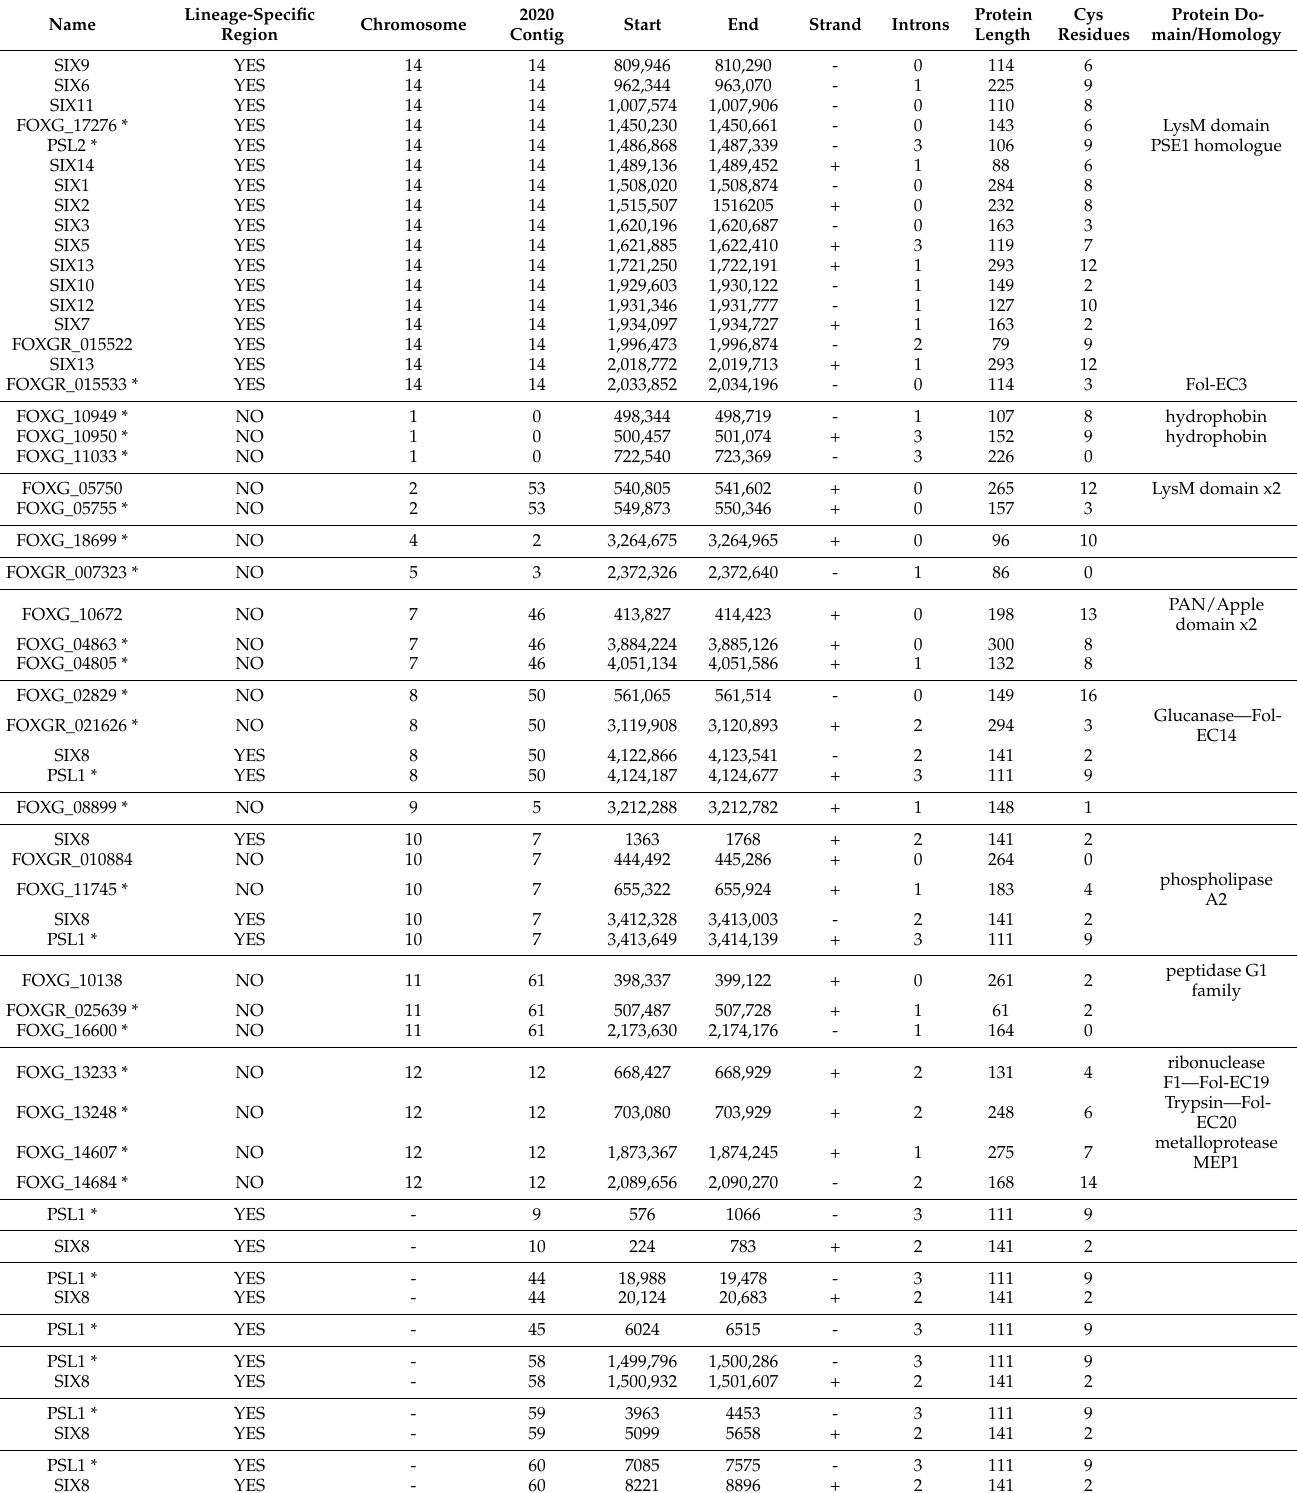
Table 1. Characteristics of 55 effector candidates with TPM values greater than or equal to that of SIX13 during Fol